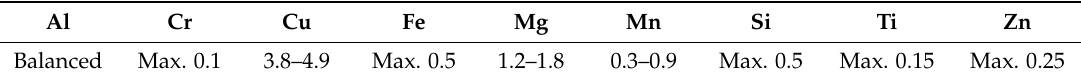
Figure 2. Micrographs of a polished surfaces of ( a ) aluminum alloy AA2024 ‐ T351 [6] and ( b ) cemented carbide tool WC ‐ Co [11]. Table 1. Chemical composition (wt. %) of the AA2024 ‐ T351 [11].